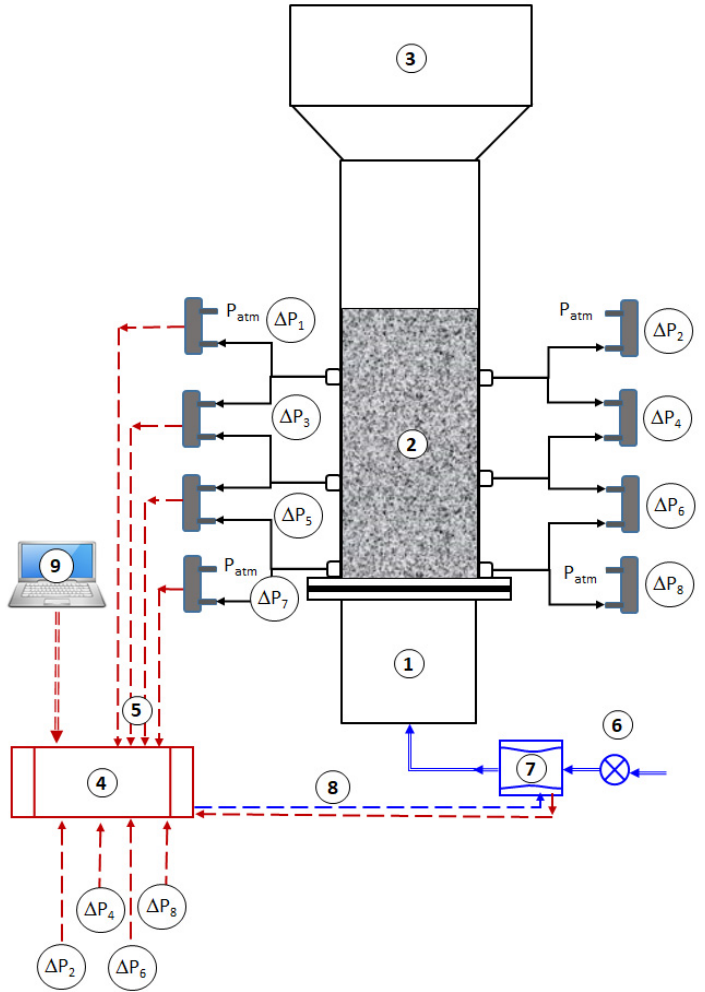
Experimental Figure 1. Experimental setup. ( 1 ) Calming section; ( 2 ) Fluidized bed test section; ( 3 ) Disengagement